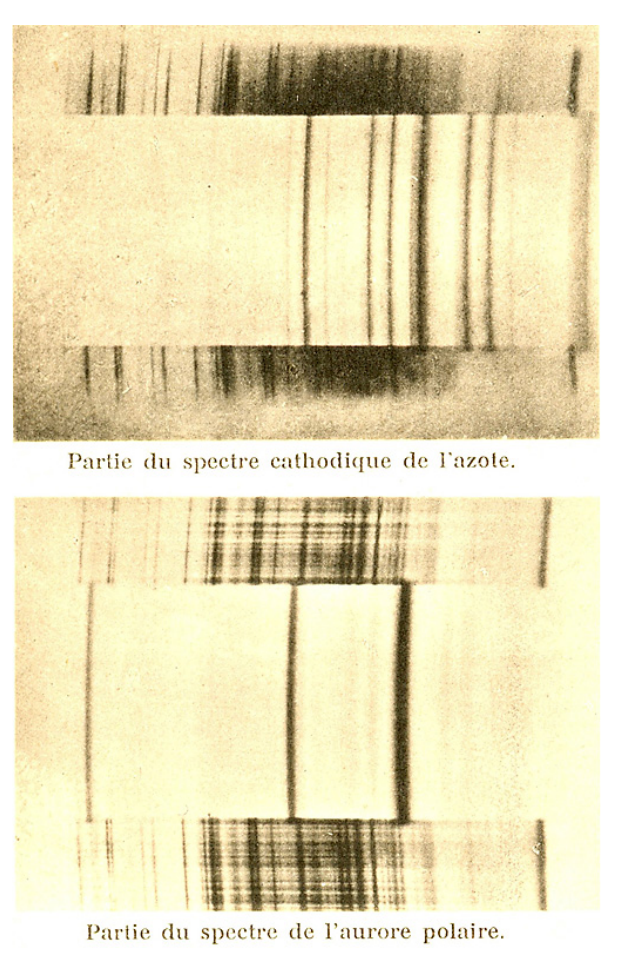
Figure 18. Spectra from Nitrogen gas (top) and from Aurora (bot- tom). Inserts are magnified sections (Paulsen,